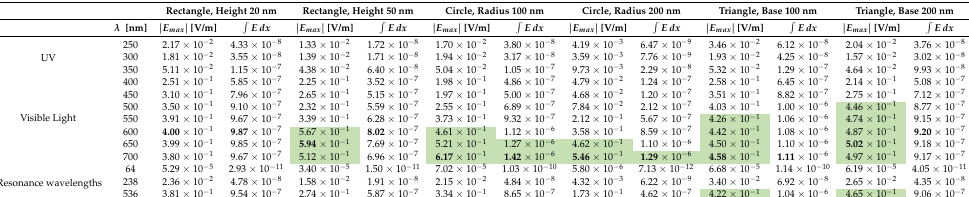
Table A7. Summary table of the results obtained for the gold nanostructures—Probe 1.